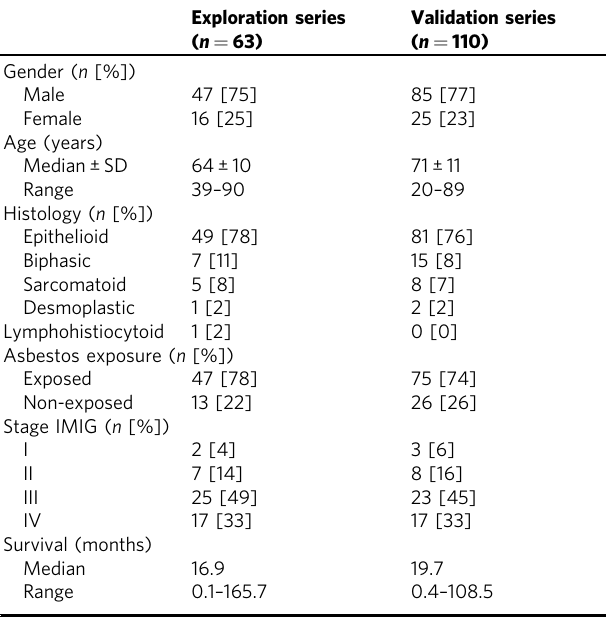
Table 1 Clinico-pathological characteristics and epidemiologic data of the series of MPM patients Exploration series Validation series ( n = 63) ( n =